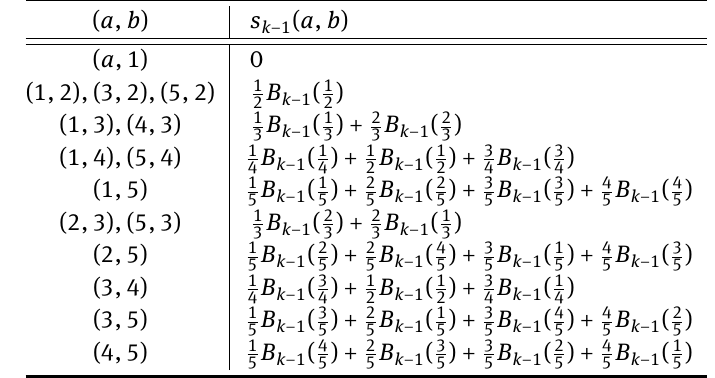
Table 1: Examples for s k −1 ( a , b ) with 1 ≤ a , b ≤ 5 and ( a , b ) =